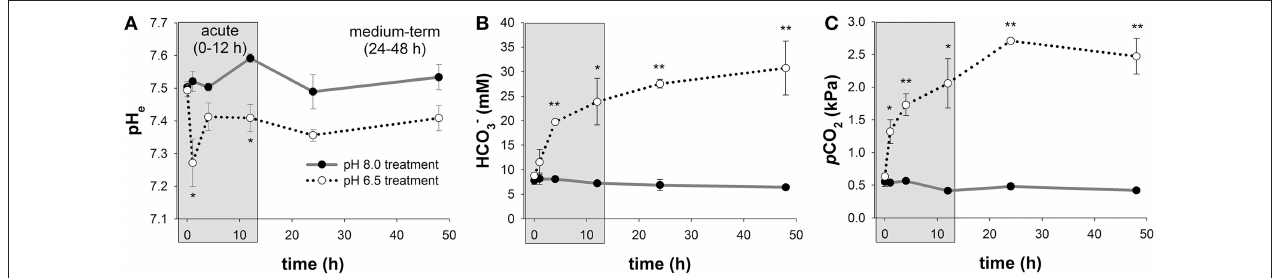
FIGURE 2 | Extracellular acid-base parameters during exposure to acidified conditions. Time series measurements of in vivo extracellular pH (pHe) (A) , hemolymph HCO − 3 levels (B), and p CO 2 (C) along the experimental period of 48h. The exposure period is separated into a short-term (gray) and medium-term (white) acclimation period. Extracellular acid-base parameters are additionally presented in a Davenport diagram in Figure S1. Asterisks indicate significant differences between pH treatments ( * p < 0.05 and ** p < 0.001 ). Bars represent mean ± SE ( n = 4